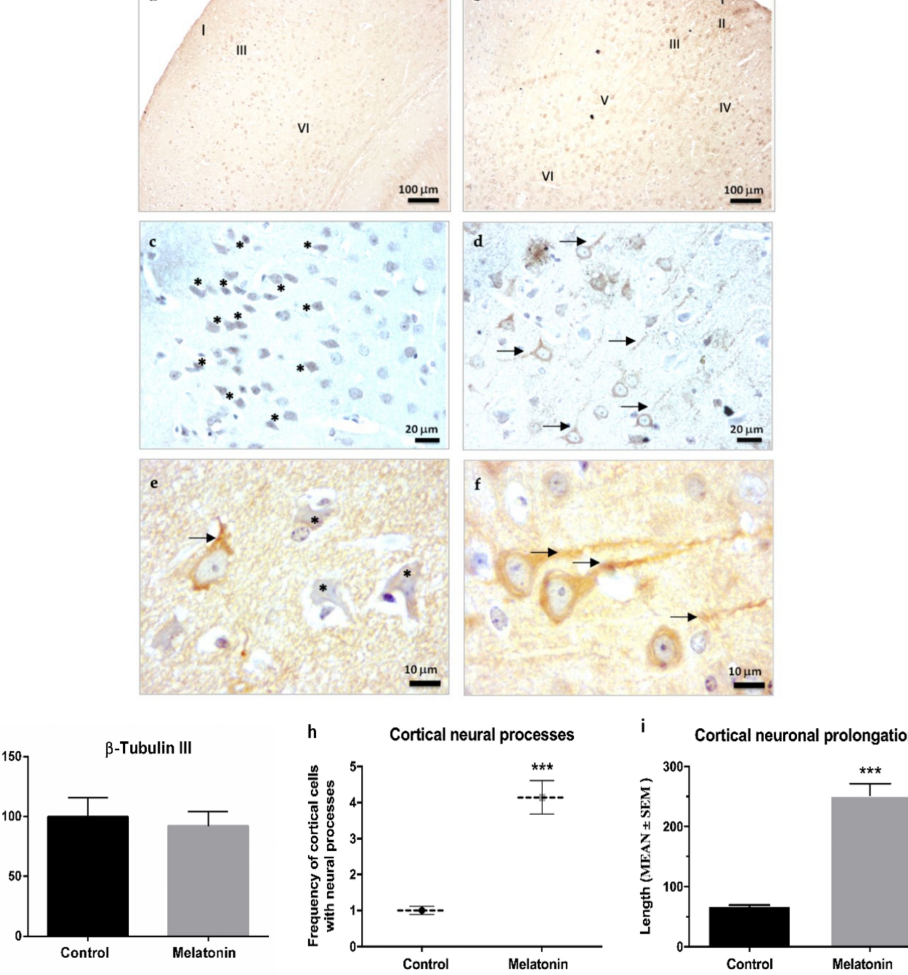
Figure 1. β -Tubulin III immunostaining in the brain cortex of SAMP8 control mice ( a , c , e ) and SAMP8 mice treated with melatonin ( b , d , f ). Asterisks show neurons under neurodegeneration (dark neurons). Arrows note neuronal prolongations in cells positive for β -Tubulin III. I, the molecular layer; II, the outer granular layer; III, the outer pyramidal layer; IV; the inner granular layer; V, the inner pyramidal layer; VI, the polymorph layer. ( g ) Bar chart shows quantification of the DAB signal with respect to the total number of nuclei at 400 × magnifications (in percentages with respect to control). ( h ) Frequency of cortical cells positive for β -Tubulin III with evident neural processes. ( i ) Length of neural prolongations in cortical cells positive for β -Tubulin III. Data are expressed as means ± SEM. *** p < 0.001 vs. control. Statistical analysis was always performed in 10 images obtained from each SAMP8 control mice ( n = 4) and SAMP8 mice treated with melatonin ( n =